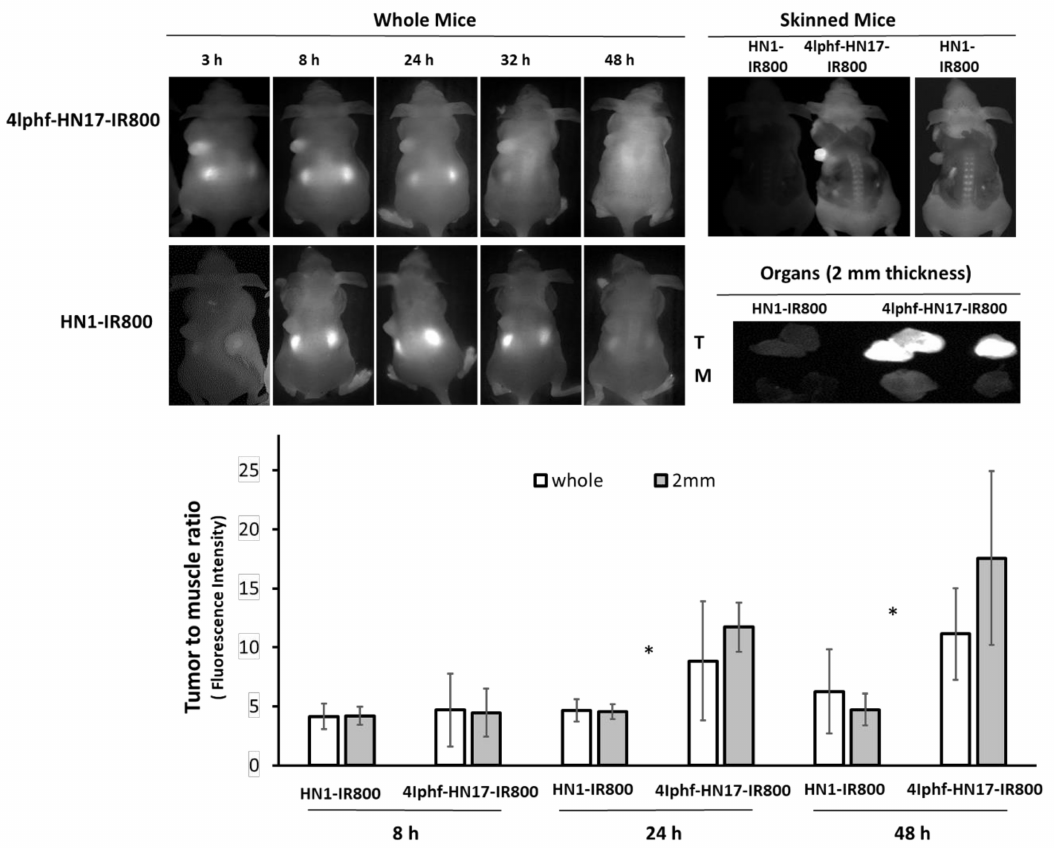
Figure 6. Fluobeam optical images of live whole mice bearing Cal 27 xenograft tumors from 3–48 h post intravenous administration of 40 nmol 4Iphf-HN17-IR800 and HN1-IR800 peptides, and at 48 h after partial removal of the skin, which partially attenuated the fluorescence emitted from the